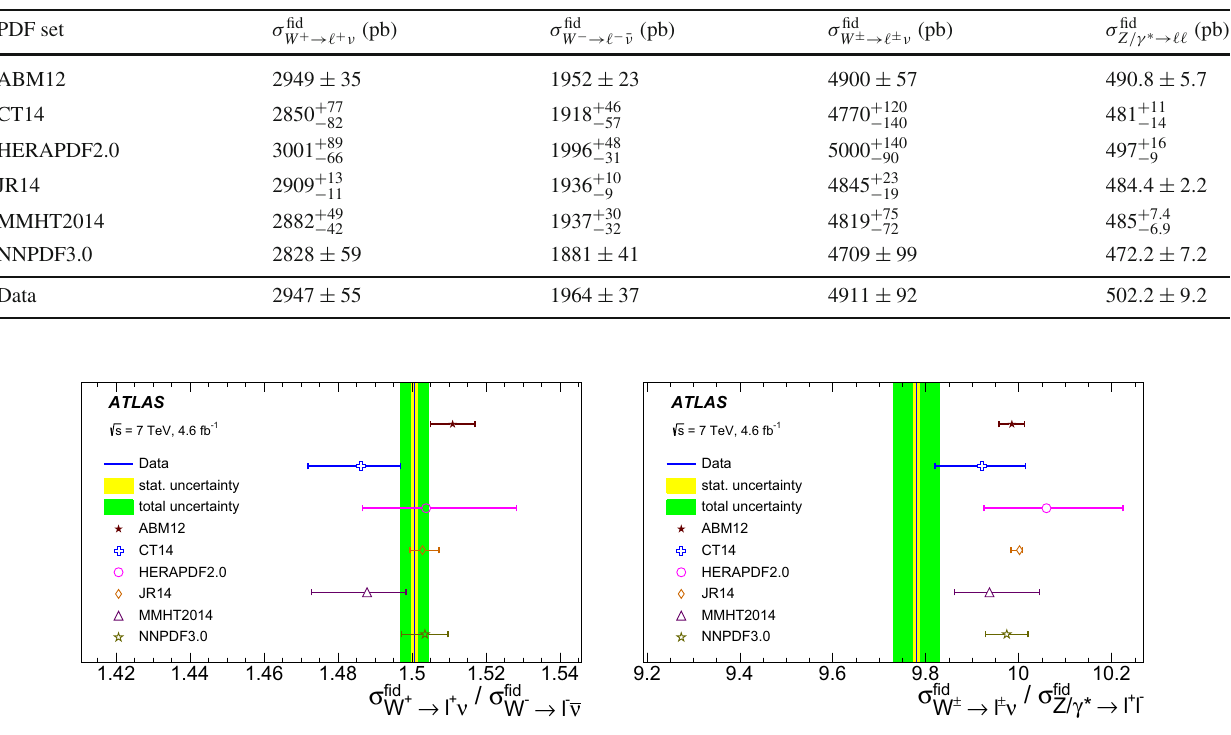
ing the different prescriptions of the PDF groups. The measured cross sections as reported before in Table 7 are shown in the last row with their total uncertainties